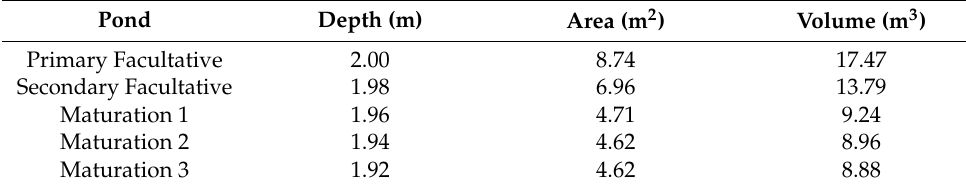
Table 1. Physical characteristics of